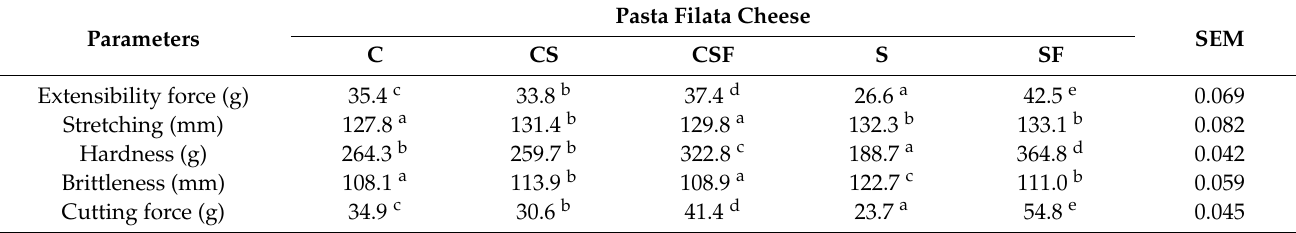
Table 3. Texture parameters of pasta filata cheeses from cow’s and sheep’s frozen milk.